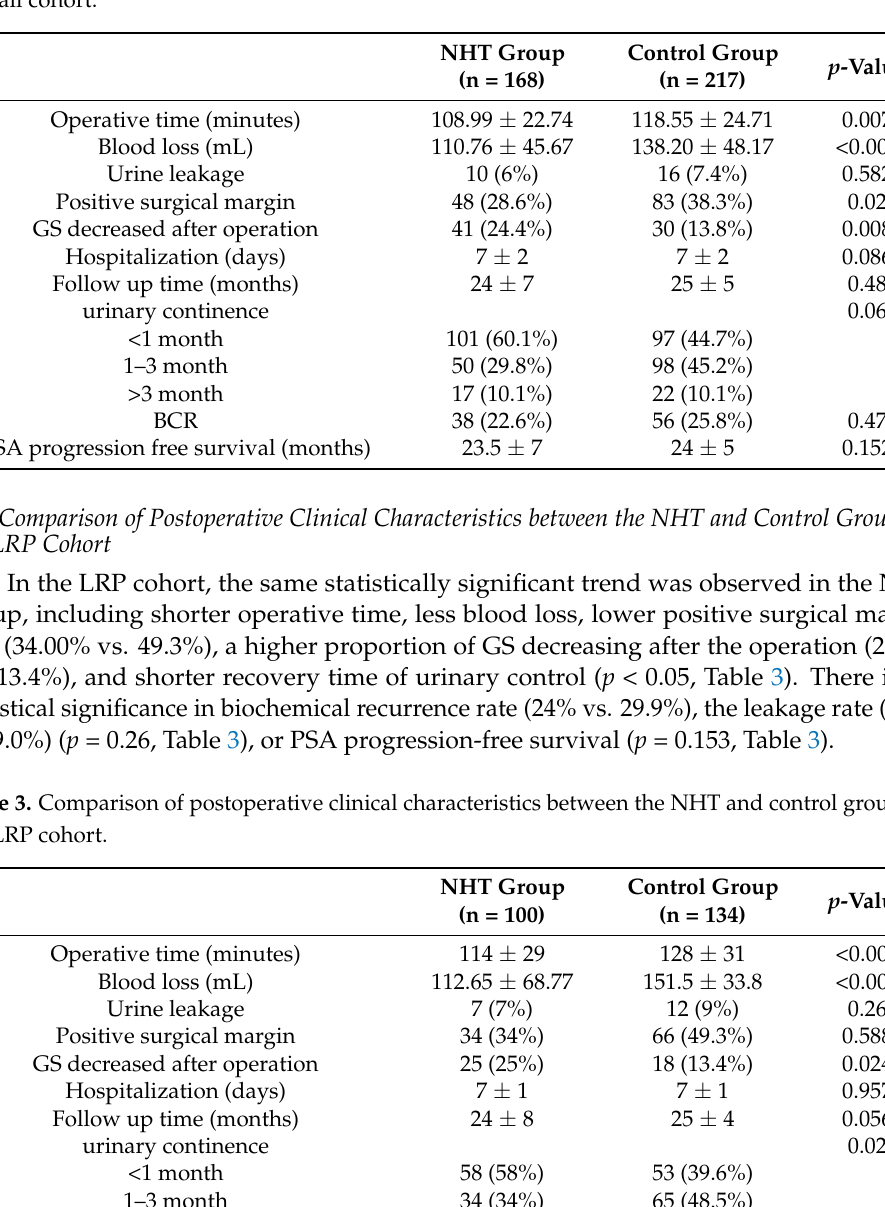
Table 2. Comparison of postoperative clinical characteristics between the NHT and control groups in overall cohort.